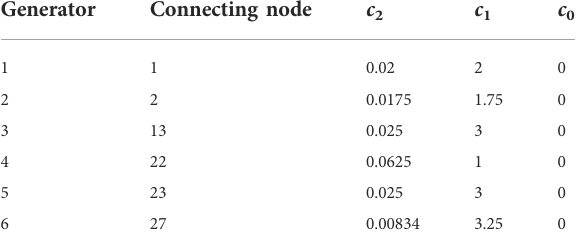
TABLE 5 The settings of the coef fi cient of each generator.